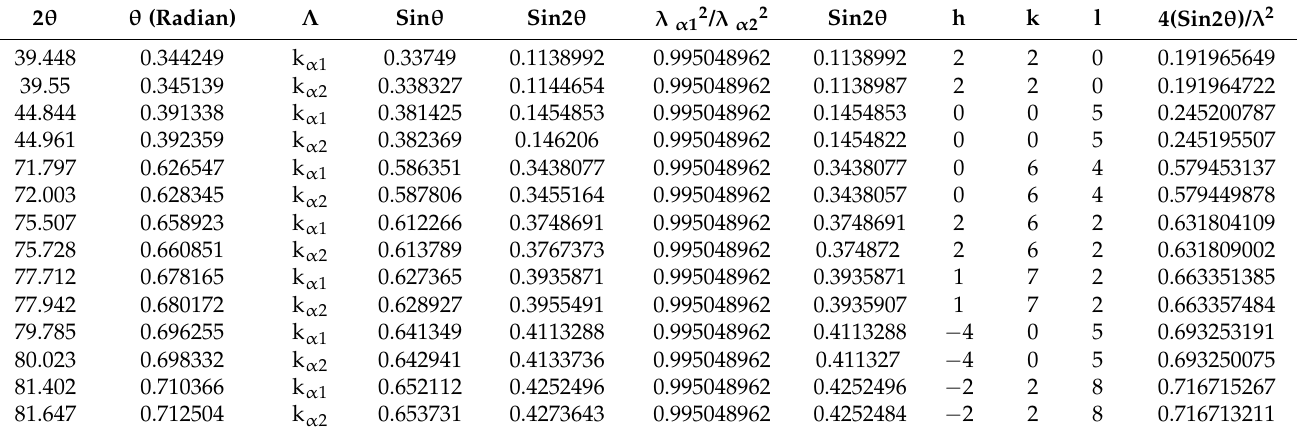
Table A4. Calculations of the d-spacing based on the Braggs equation for the starting